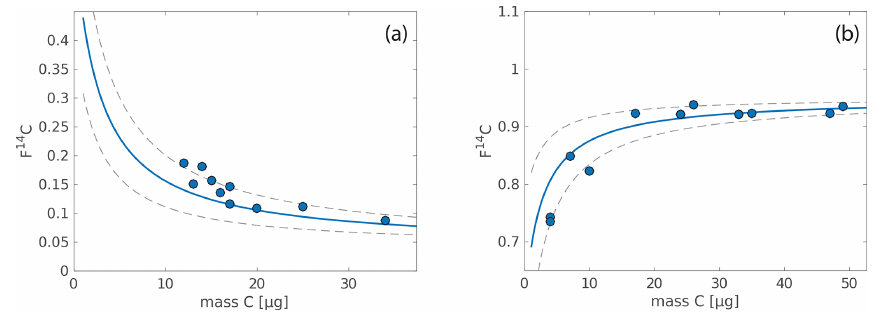
Figure 2. Blank assessment associated with GDGT isolation. (a) The F 14 C dead standard (lignite) tracing a modern constant contamination of 1.55µgC. (b) The F 14 C modern standard (topsoil composite) tracing a radiocarbon dead constant contamination of 1.07µgC. The solid line indicates the best fit of contamination mass and radiocarbon signal for both sets of samples considered jointly. The gray dotted lines show the 1 σ error